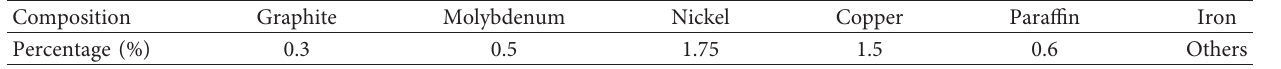
Table 1: Composition of the green compacts.